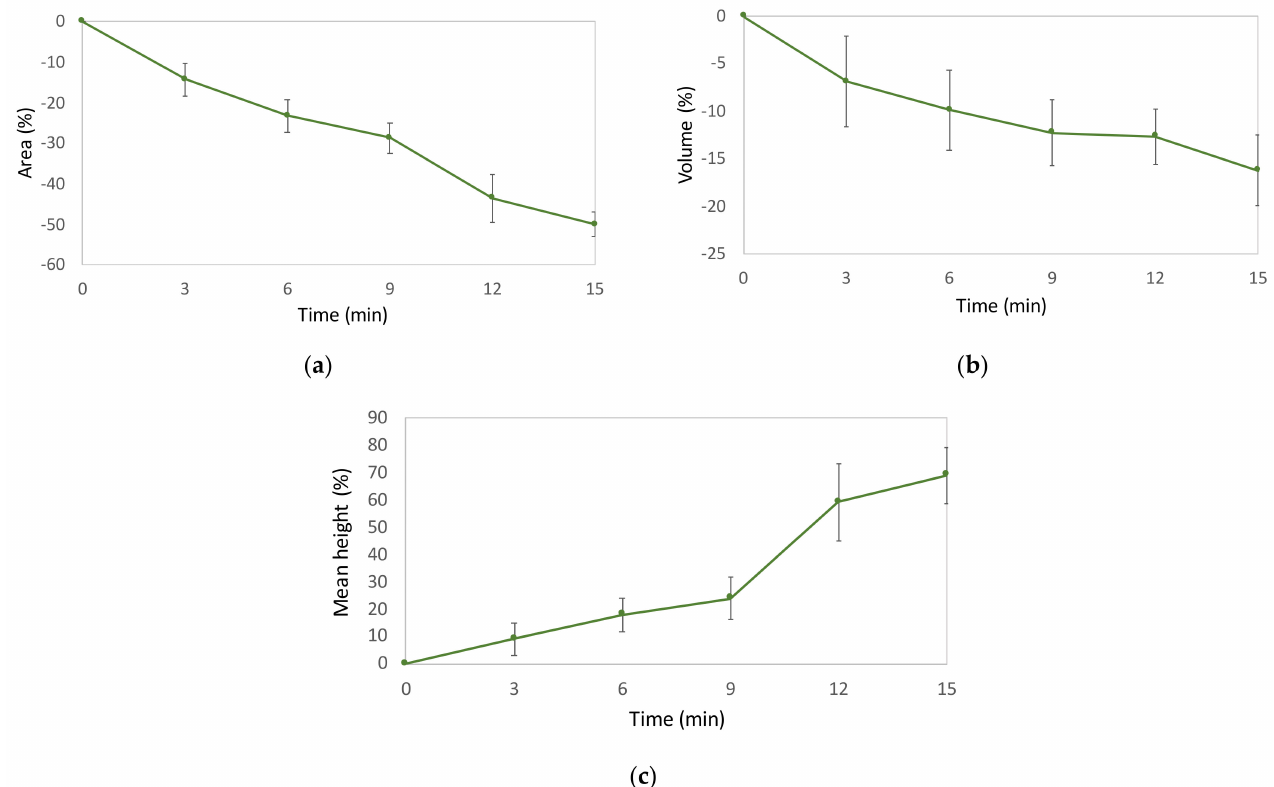
Figure 10. Percental variations in area ( a ), volume ( b ), and mean height ( c ) obtained in single-cell experiments ( n = 5) relative to 0, 3, 6, 9, 12, and 15 min of Cyt-D